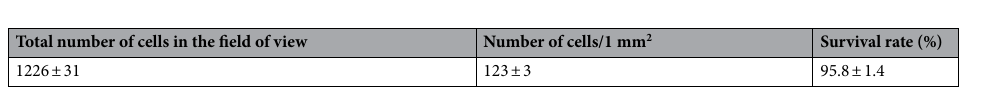
Table 1. Number of cells, density and survival rate defined by Calcein AM/Ethidium staining.